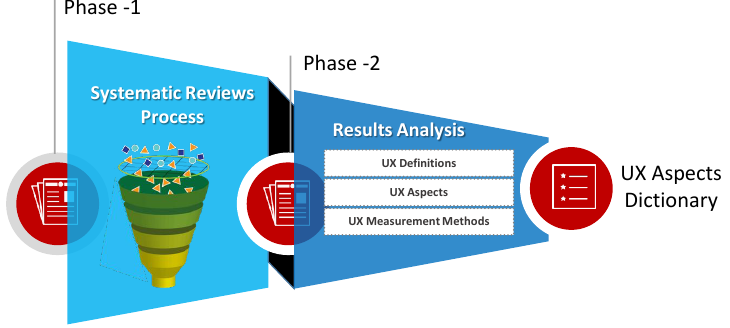
Figure 4. Identifying UX existing aspects for aspect configuration